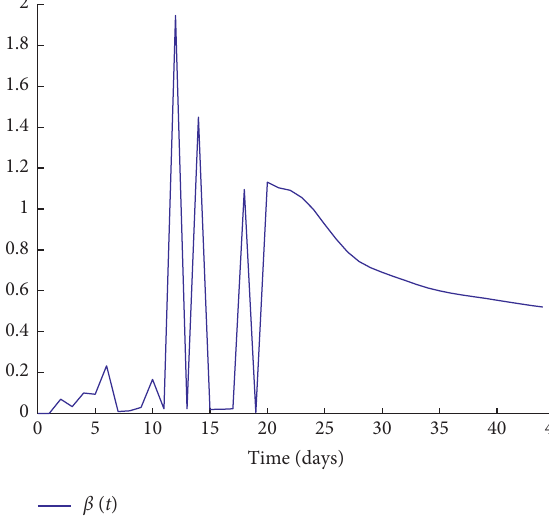
Figure 18: Estimation of the Malthusian parameter from reported filtered data (Italy) and lsqcurvefit Matlab function.